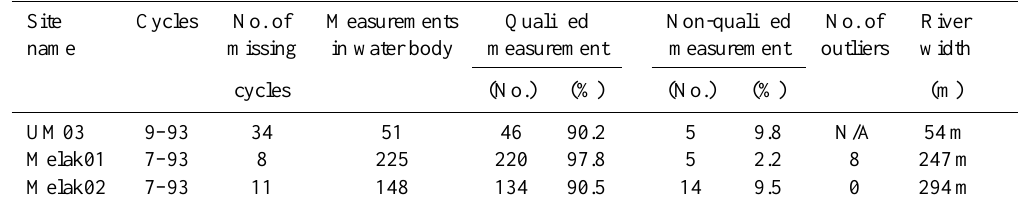
Table 1. The number of qualified and non-qualified altimeter measurements and outliers for study sites at Mahakam River.